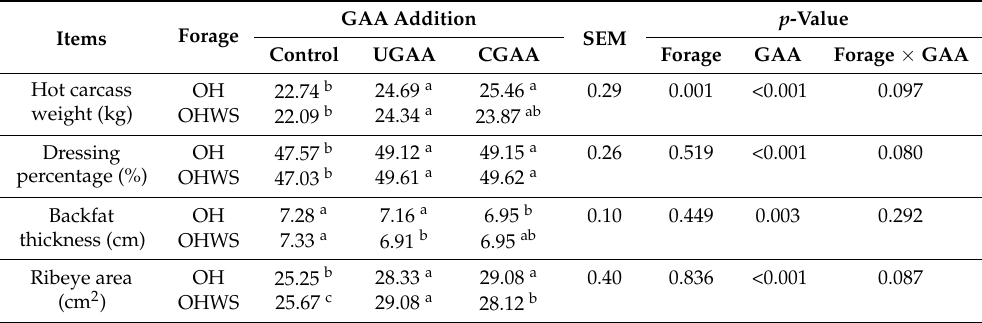
Table 4. Effects of forage type and GAA addition on slaughter performance in lambs.